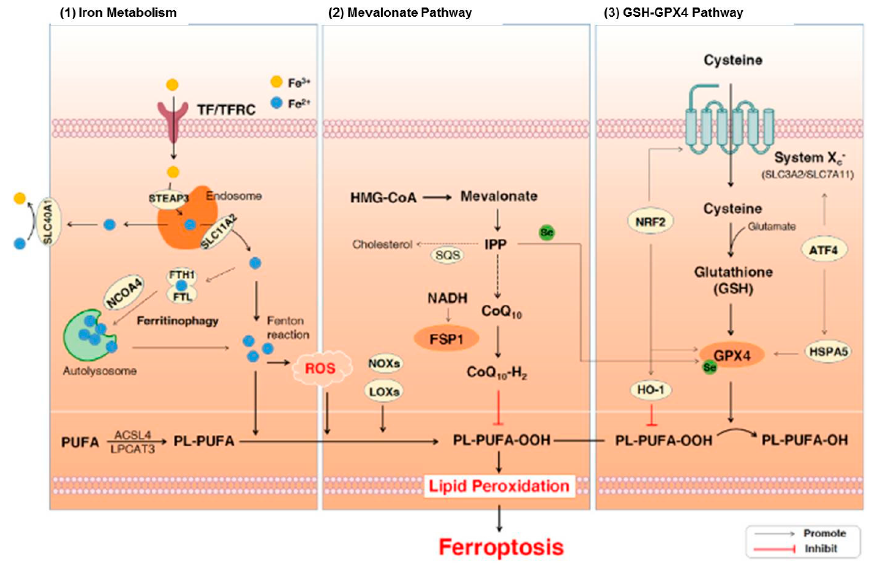
Figure 2. The signaling pathways involved in ferroptosis [101]. Abbreviations: ATF4, activating transcription factor 4; CoQ10, coenzyme Q10; Fe3+, ferric cation; Fe2+, ferrous cation; FSP1, ferroptosis suppressor protein 1; FTH1, ferritin heavy chain 1; FTL, ferritin light chain; GPx4, glutathione peroxidase 4; GSH, glutathione; HMG-CoA, 3-hydroxy-3-methylglutaryl coenzyme A; HO-1, heme oxygenase-1; HSPA5, heat shock protein 70 family protein 5; IPP, isopentenyl pyrophosphate; LOXs, lipoxy-genases; NADH, nicotinamide adenine dinucleotide; NCOA4, nuclear receptor coactivator 4; NOXs, NADPH oxidases; NRF2, nuclear factor erythroid 2-related factor 2; PL-PUFAs, phospho-lipids-containing PUFAs; PUFA-OOHs, hydroperoxides derivatives of PUFAs; PUFAs, polyun-saturated fatty acids; ROS, reactive oxygen species; SQS, squalene synthase; TF, transferrin; TFRC, transferrin receptor. Figure reproduced with permission from Ref [101]. Copyright 2021, Elsevier.